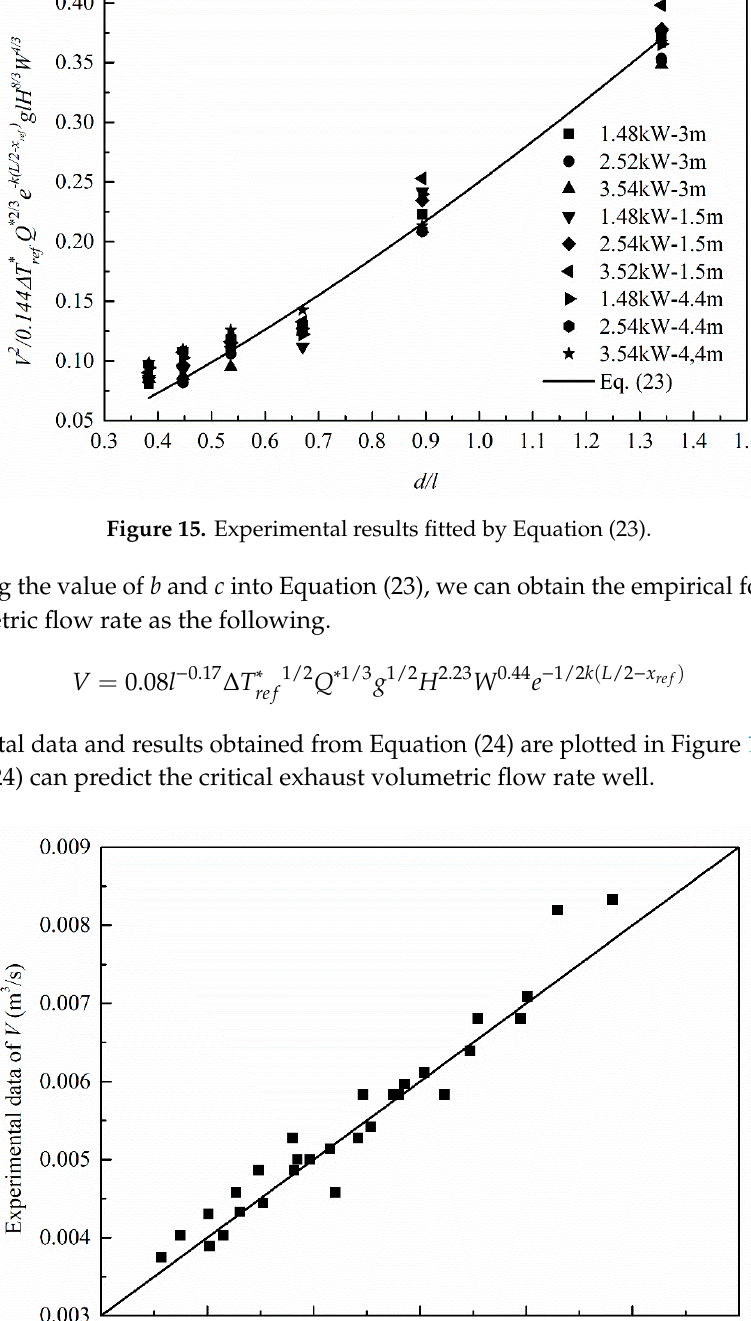
Figure 16. Comparisons of critical exhaust volumetric flow rate between experimental results and proposed empirical Equation (24).